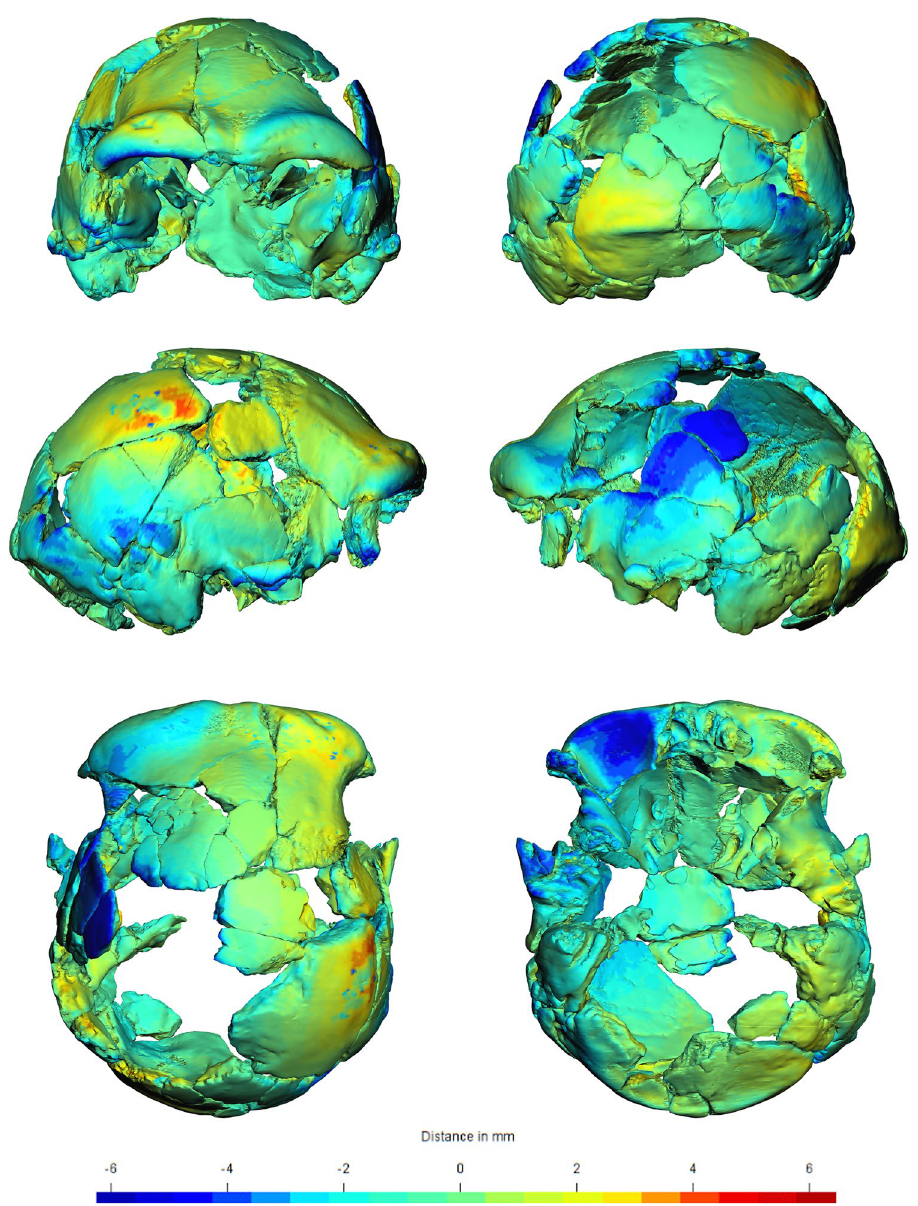
Figure 7. The retrodeformed Ceprano calvarium. Differences from our digital reconstruction (reported in Fig. 5) are expressed by colors (ranging from − 6 to 6 mm). These colors represent inter mesh distances; moving toward the yellow-red extreme of the spectrum we find the regions of the new reconstruction that are pushed inward and are now less angulated with respect to the non-deformed reconstruction; vice versa for the blue